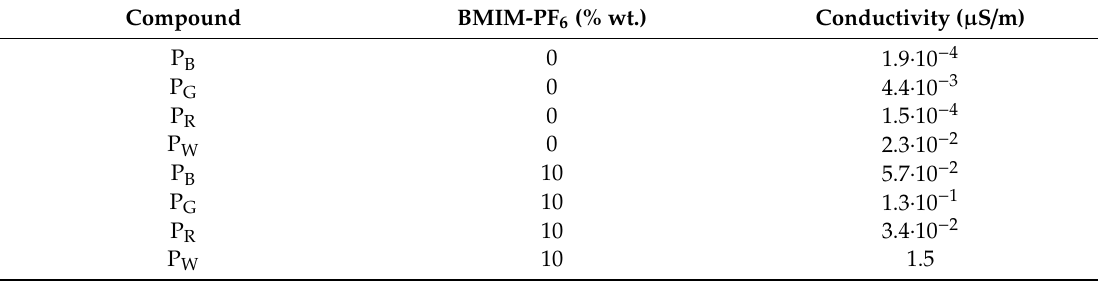
Table 3. Electrical conductivity measured on neat polymeric samples and